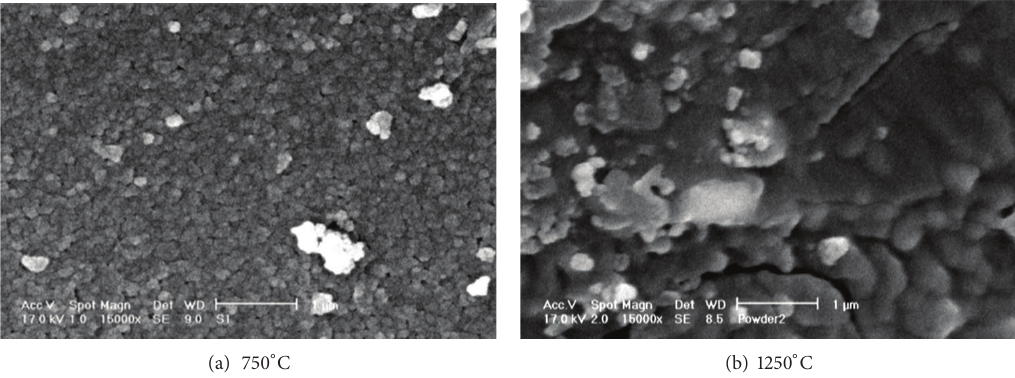
Figure 3: SEM images of Al 2 O 3 nanoparticles prepared by urea calcined at (a) 750 ∘ C and (b) 1250 ∘